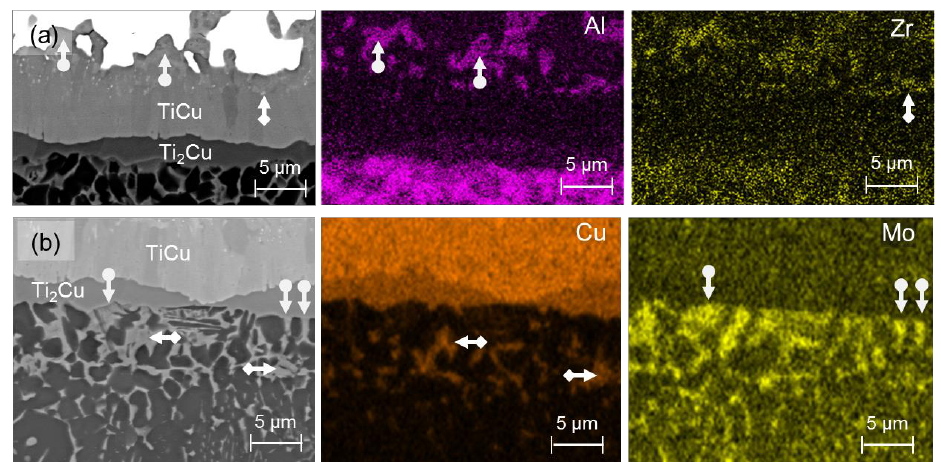
Figure 2. EDS mapping of the cross section of the brazing joint Ti6242/Ag28Cu. ( a ) An Al-rich phase (marked with arrows, probably TiCu 2 Al) which also contains Zr can be recognized clearly. ( b ) Enrichment with the elements Cu and Mo in separate areas (marked with arrows) can be seen below the Ti 2 Cu layer.